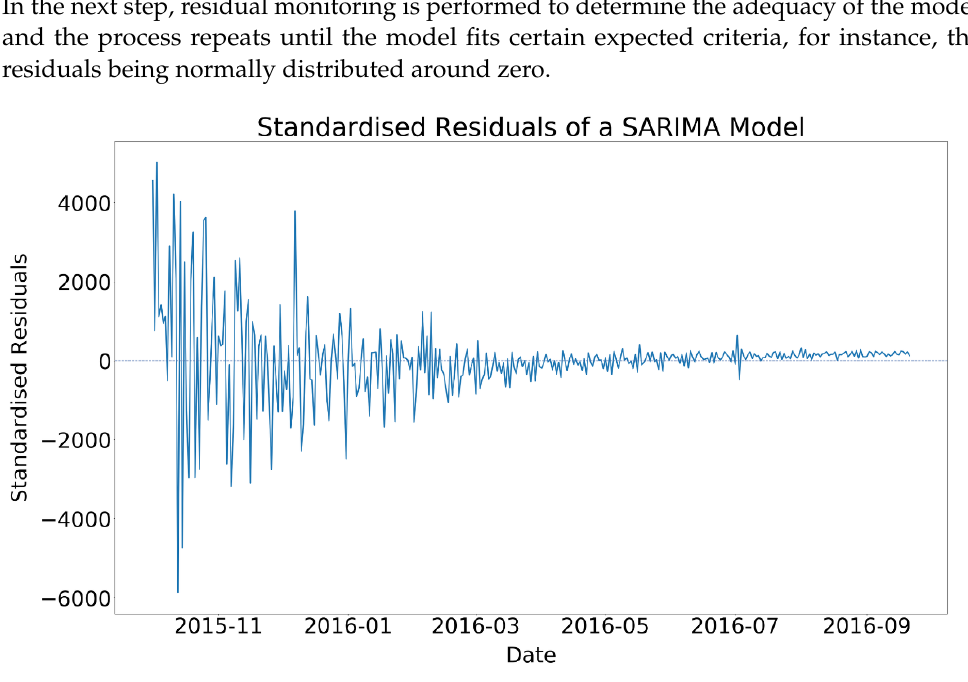
Figure 13. An illustration of the diagnostic validation phase during the fitting of SARIMA